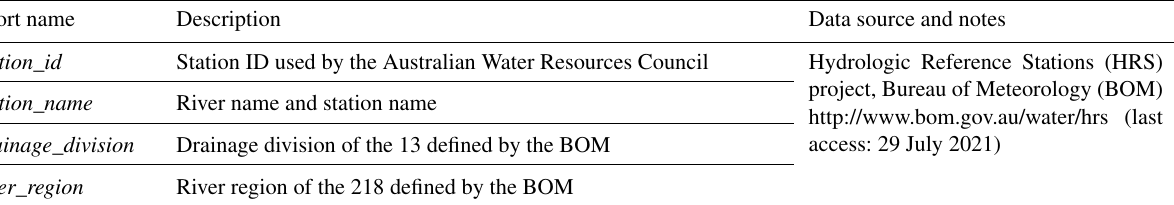
Table 1. Basic catchment information provided in the attribute table of CAMELS-AUS. Short